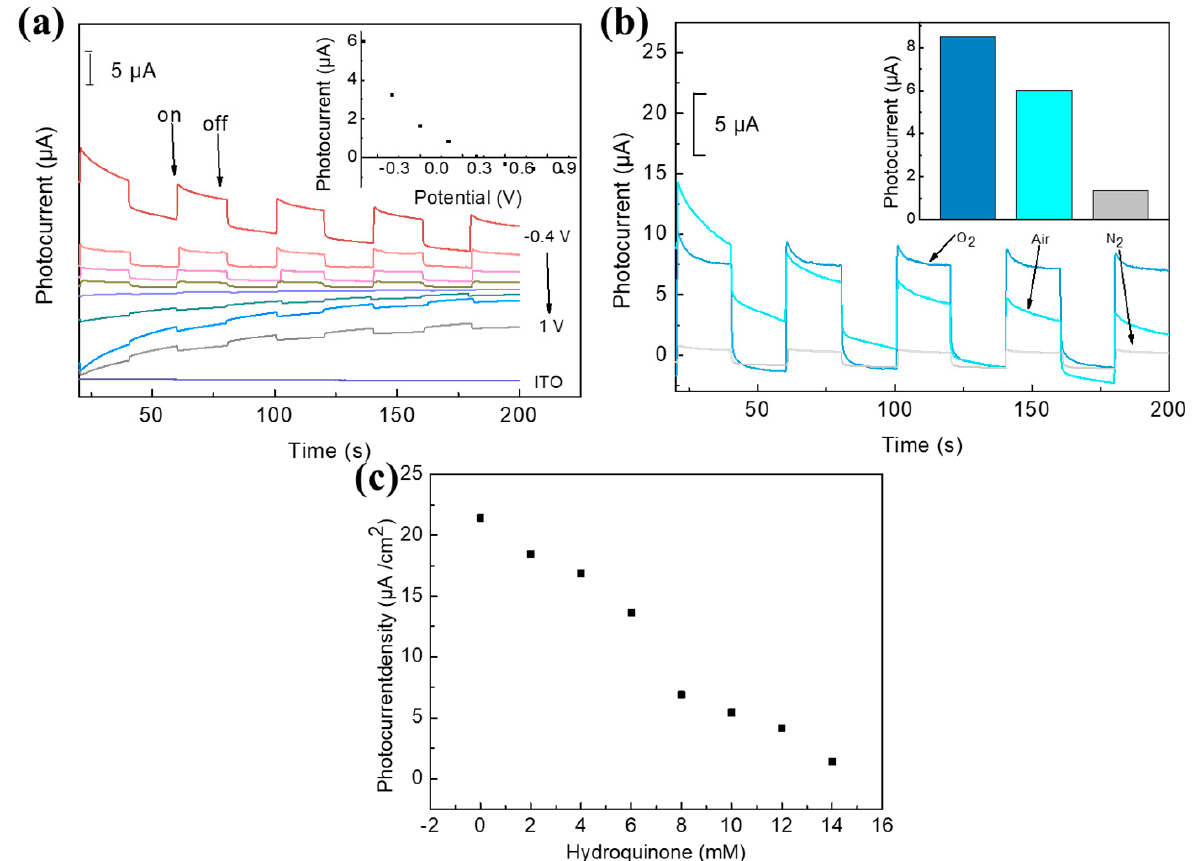
Figure 7. ( a ) Photocurrents responding to light irradiation on and off for bare ITO and the [Re(CO) 3 Cl(L)] film on ITO at bias potentials from top to bottom: − 0.4, − 0.2, 0, +0.2, +0.4, +0.6, +0.8 and +1 V vs. SCE. The inset: A plot of the photocurrent vs. the bias potentials. ( b ) Photocurrent responses and bar charts (inset) for the film in O 2 -, air- and N 2 -equilibrated electrolytes at a bias potential of –0.4 V vs. SCE. ( c ) Effects of the concentrations of the electron donor of hydroquinone on the photocurrent density of the film in air-equilibrated 0.1 M Na 2 SO 4 at a bias potential of − 0.4 V vs. SCE.